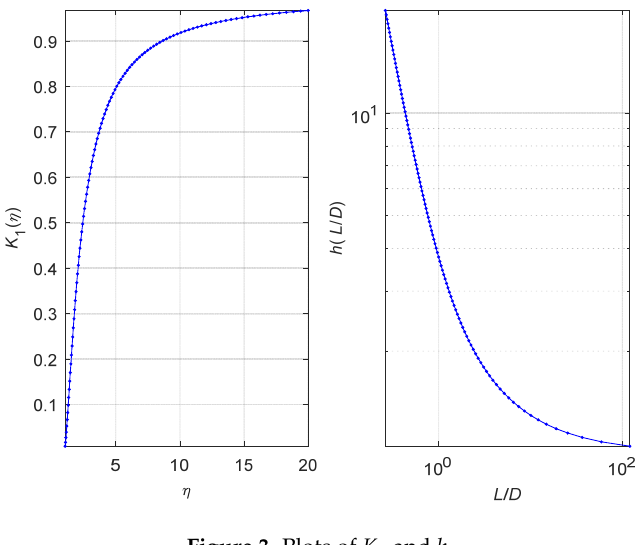
Figure 3. Plots of K 1 and h .